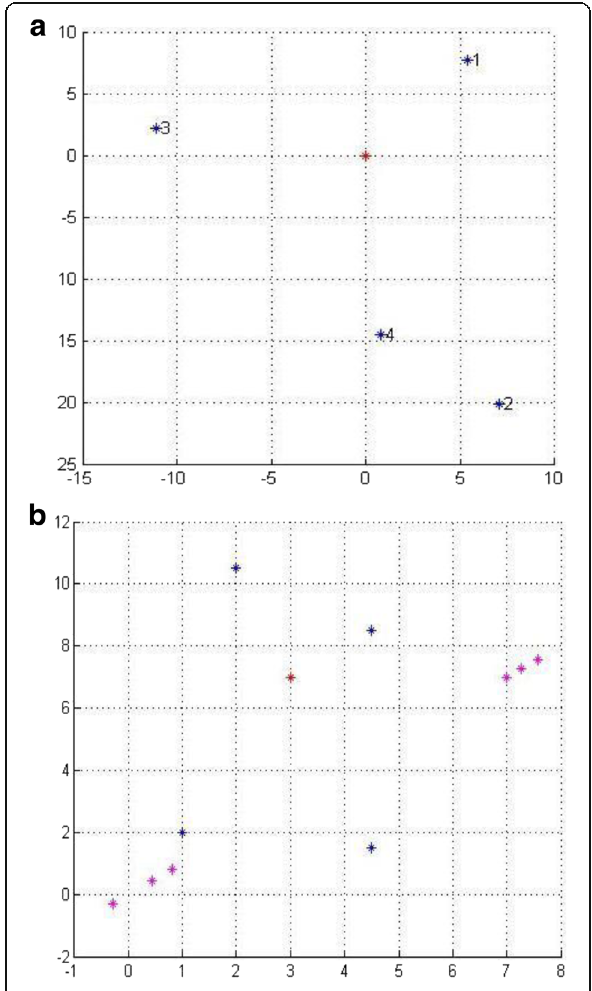
Fig. 10 Results: ( a ) without reflectors; ( b ) with reflectors (red star is the source location; pink stars are reflector